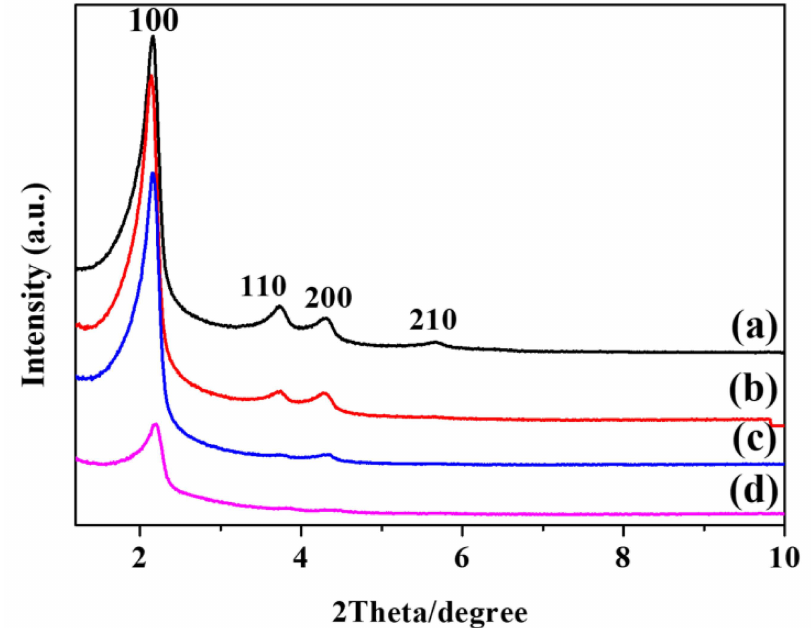
Figure 4. Low-angle XRD patterns of ( a ) MCM-41, ( b ) MCM-41-TMSPM, ( c ) MCM-41-PAA, and ( d ) Ca@MCM-41-PAA_5-FU.